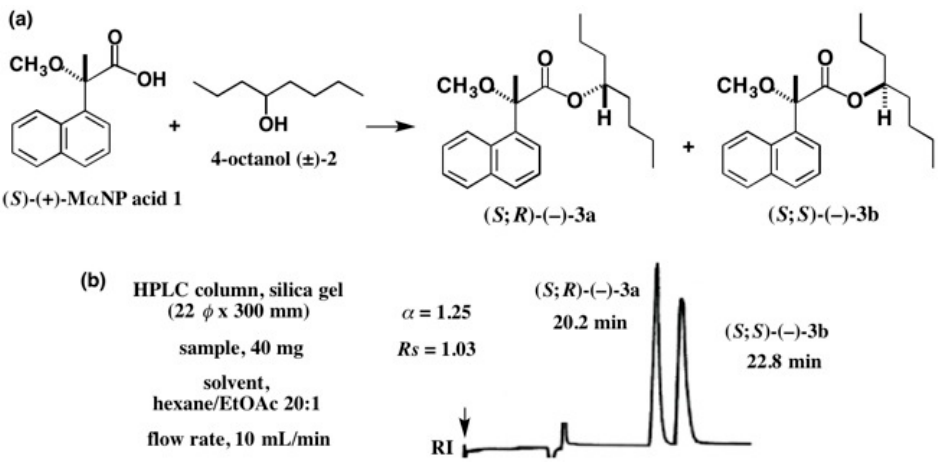
Figure 1. Preparation of diastereomeric 4-octanol ( S )-(+)-2-methoxy-2-(1-naphthyl)propionic acid (M α NP) esters 3a and 3b ( a ) and separation by high performance liquid chromatography (HPLC) on silica gel ( b ). Redrawn with permission from [13].